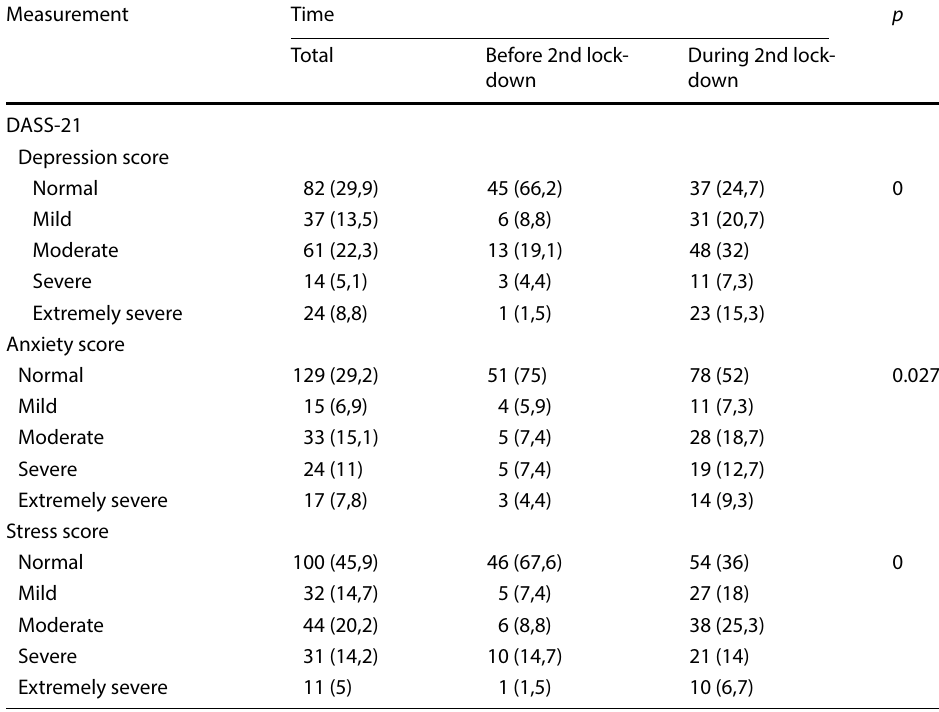
Table 3 Severity Categories of Emotional Distress Measures for Parents by Groups ( N =